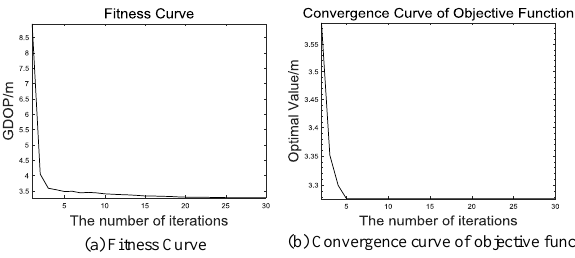
Fig. 2. Population mean fitness and target convergence curves -3 aircrafts.